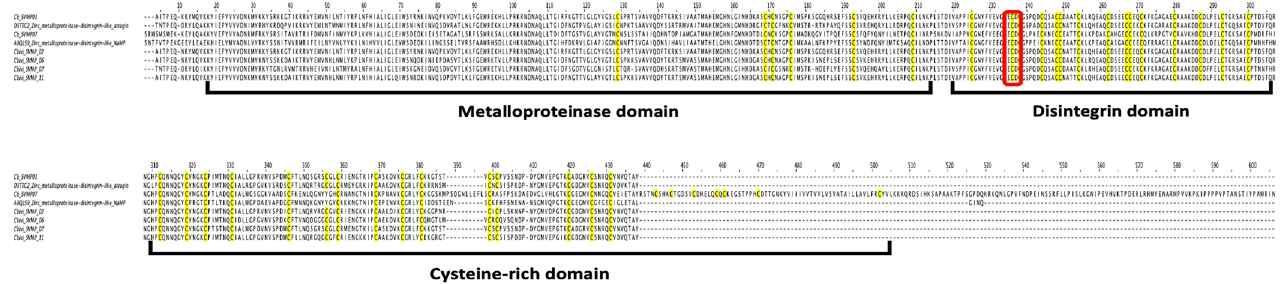
Figure 7. Multiple sequence alignment of snake venom metalloproteinase (SVMP) transcripts (Cb_SVMP01 and Cb_SVMP07) of Calliophis bivirgata flaviceps with other annotated sequences. Brackets in black: metalloproteinase, disintegrin and cysteine-rich domains; red regions: ECD